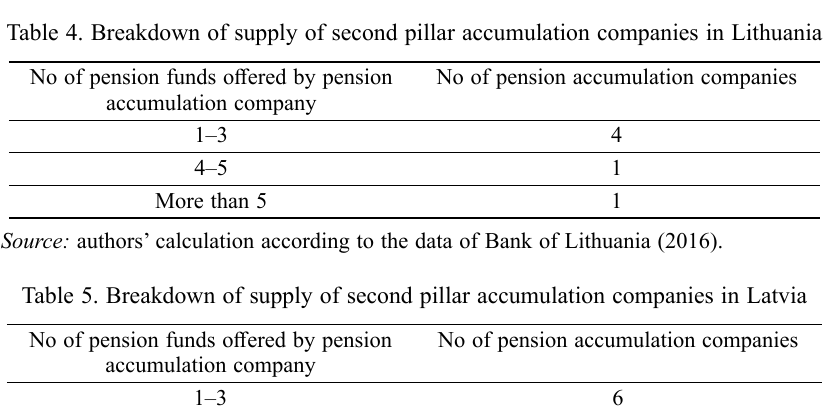
Table 3. Breakdown of second pillar pension funds according to investment risk in Estonia No of companies, offering at Pension fund group Investment risk No of pension funds least 1 pension fund in a group Conservative Very low 6 5 Balanced Low 5 5 Progressive Medium 5 5 Aggressive Medium / High 4 4 Total: 20